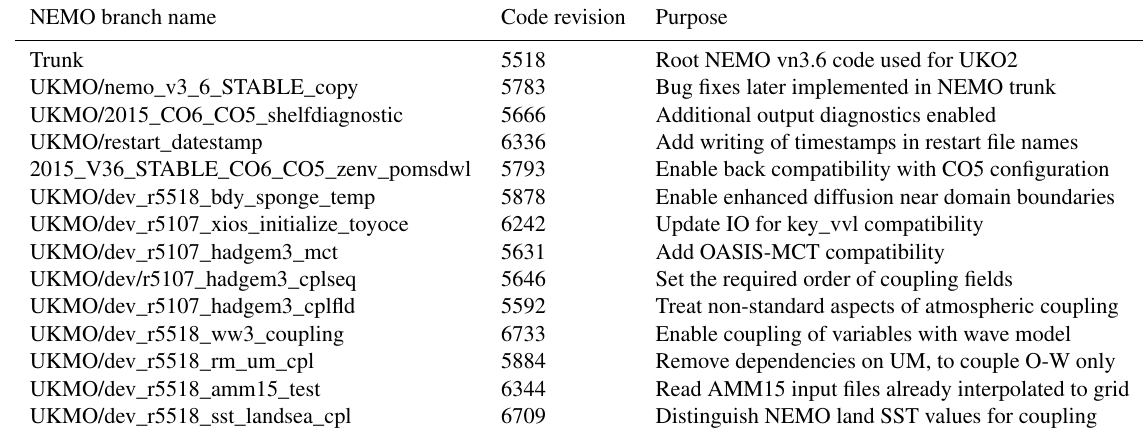
Table C4. Summary of NEMO code branches merged and used in the UKC2 system, containing relevant adaptations from the baseline trunk code at version 3.6 (revision 5518). Model codes are accessible via http://www.nemo-ocean.eu (NEMO Community, 2017). Registered users can directly access each code branch at the revision used in UKC2 by following the direct code revision links provided.